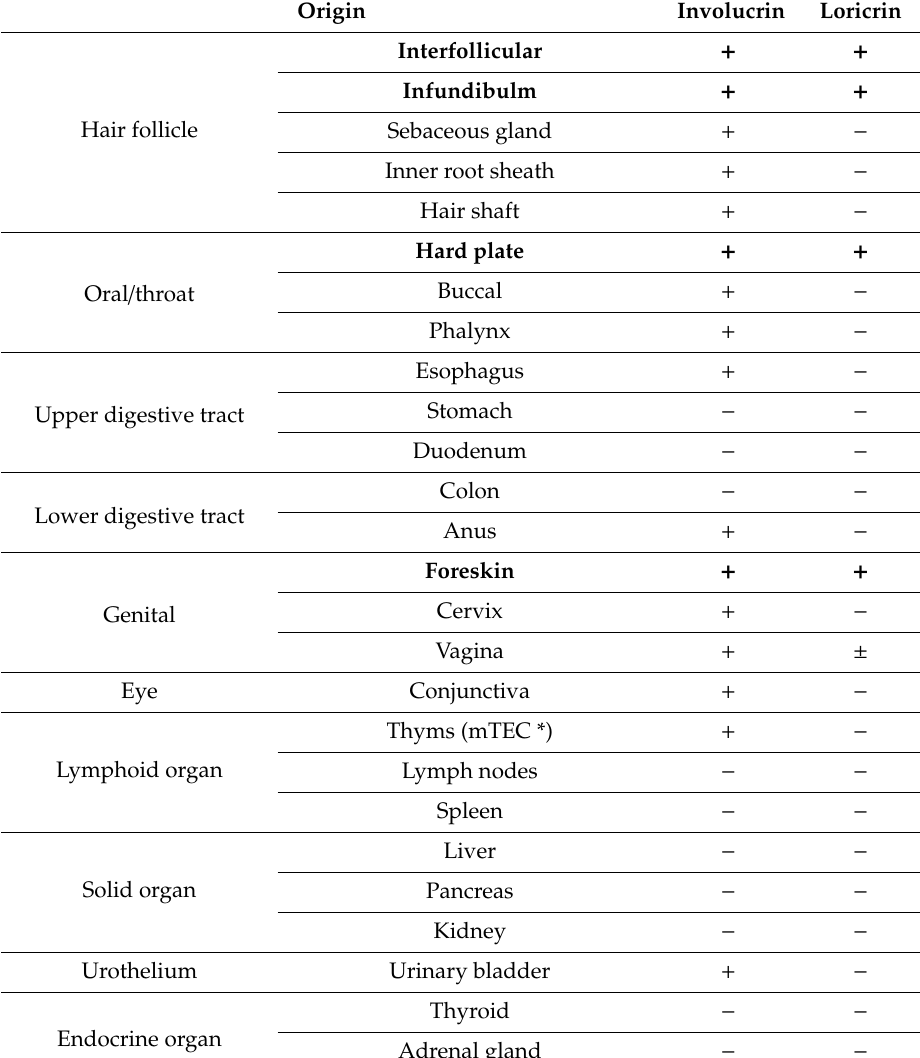
Table 1. Distribution of major CE proteins in various human